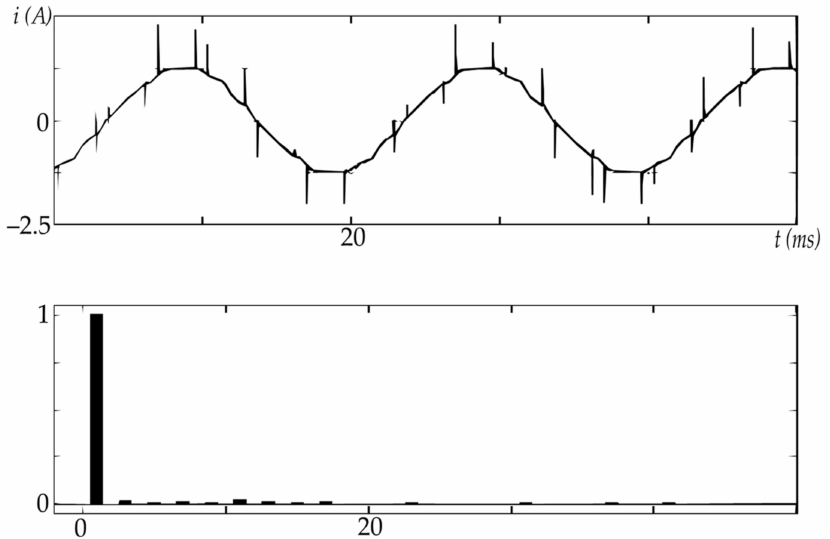
Figure 11. The input current of the 6 × 6 MMC (sending end of the line) working under the “two closest” approach to the control procedure with 10 ◦ phase shift and its harmonic spectrum.